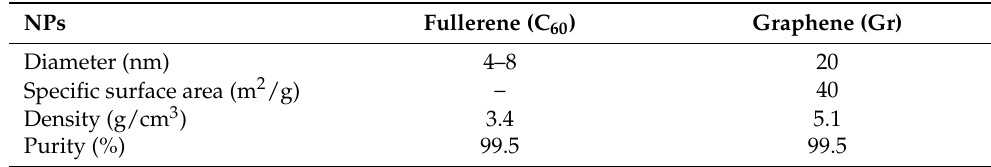
Table 2. Nanoparticles’